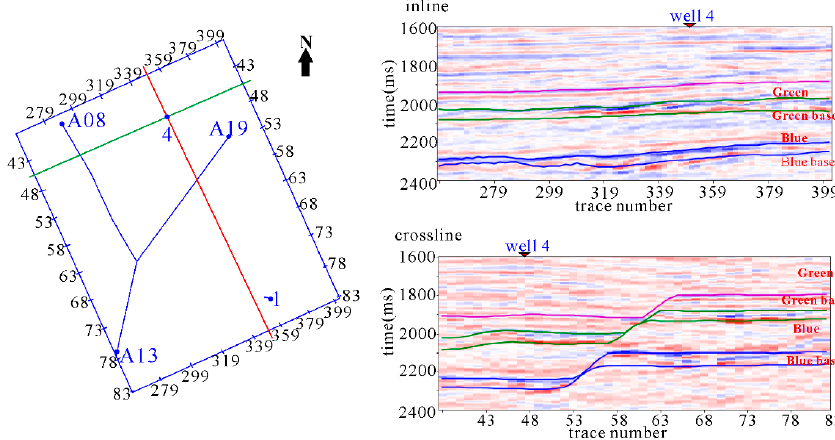
Figure 6. Study area with well locations (left) and Seismic data (right).